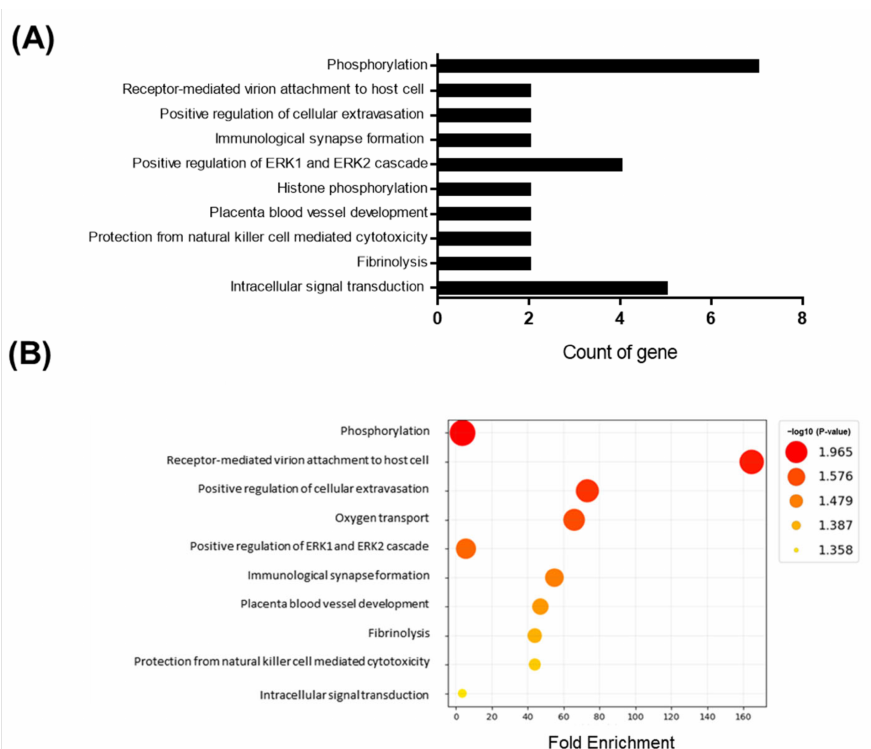
Figure 2. GO enrichment analysis for genes based on DEGs data. Y-axis represents the enriched GO terms; X-axis ( A ) represents the top 10 amount of the genes enriched in GO terms; X-axis ( B ) represents the ratio of the genes enriched in GO terms. The color and size of each bubble represent enrichment significance and the number of genes enriched in a GO term respectively. p < 0.05 was used as the threshold to select GO. GO—gene